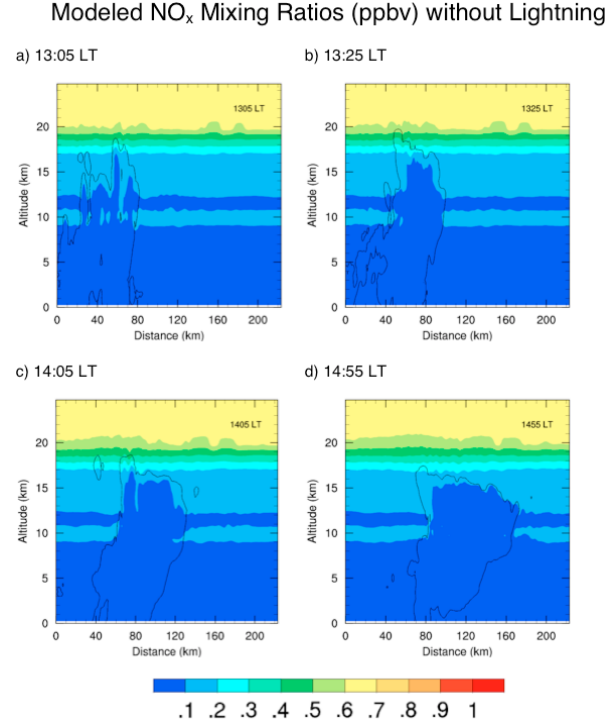
Fig. 13. Time series of vertical cross sections of NO x mixing ratios for simulations with lightning NO production of 500molesflash − 1 at (a) 13:05LT, (b) 13:25LT, (c) 14:05LT, and (d) 14:55LT, ori- ented 130 ◦ from north through the storm core. The thin black line indicates the 0.01gkg − 1 total condensate